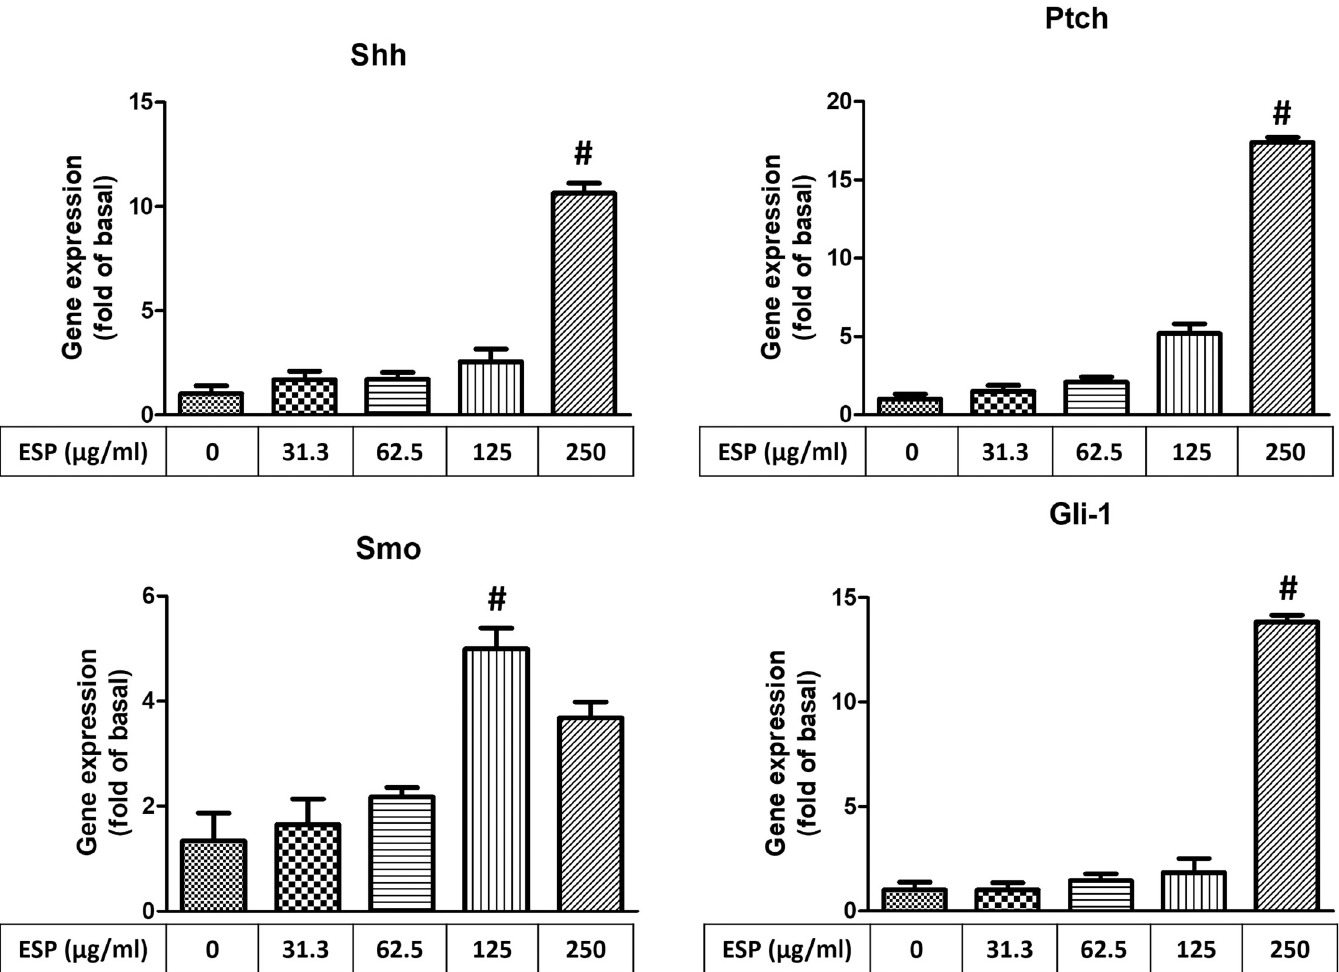
Fig 7. Excretory/secretory products induce gene expressions of Shh signaling pathway. Cells were treated with 0, 31.3, 62.5, 125, and 250 μ g/ml A . cantonensis L5 excretory/secretory products (ESPs) for 12 h. The mRNA expression levels of Shh signaling pathway-related molecules (Shh, Ptch, Smo, and Gli-1) were detected by Real- Time qPCR. The data are expressed as the means ± SD from three independent experiments ( n = 3). # P < 0.01, compared with the respective values of cells treated with 0 μ g/ml A . cantonensis L5 ESPs for 12